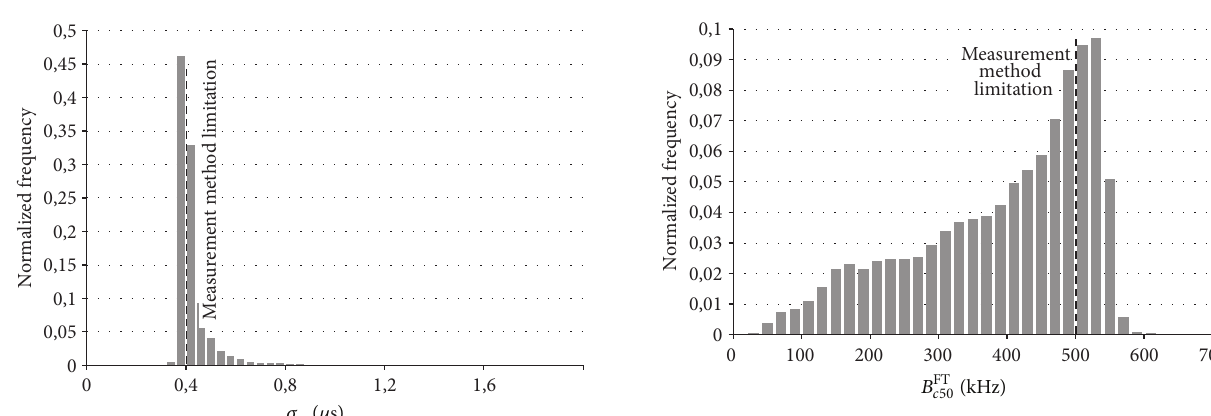
Figure 7: Histogram of rms delay spread values measured in flat terrain.